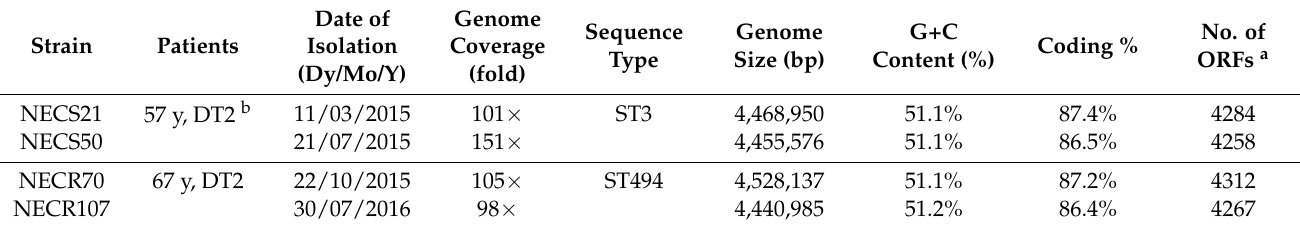
Table 4. Escherichia coli genomic features isolated from DFOM of two patients at two periods.